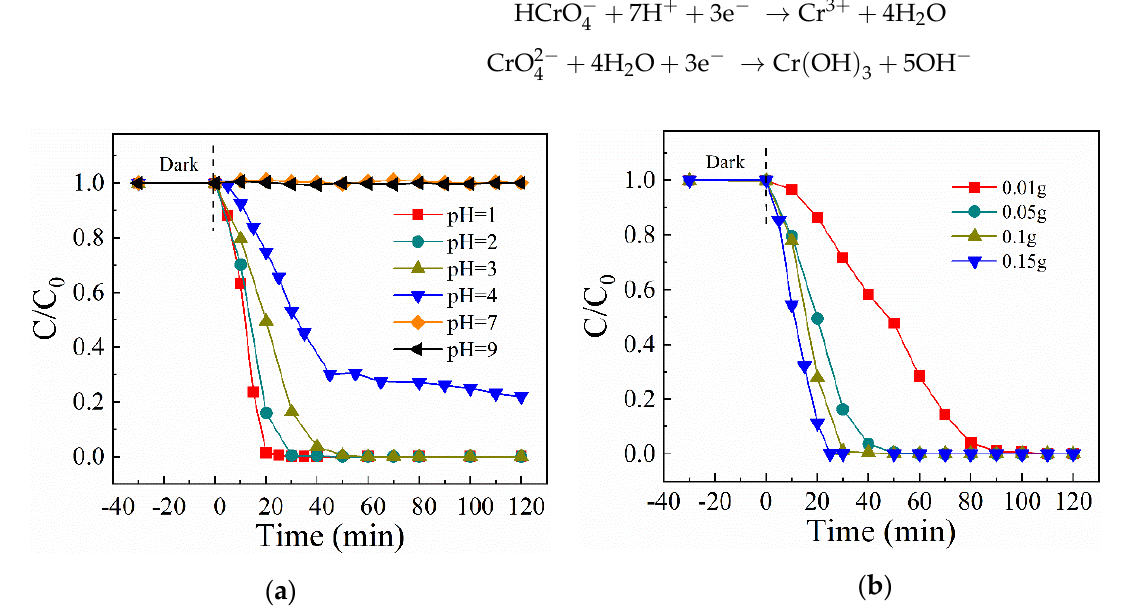
Figure 6. Effect of ( a ) initial pH and ( b ) U—CN dosage on photocatalytic Cr(VI) reduction (Vary conditions are based on the control experiment: Cr(VI) = 50 mg/L; U—CN mount = 50 mg; reaction volume = 150 mL; citric acid = 0.9 Mm; pH = 3; white light irrigation).